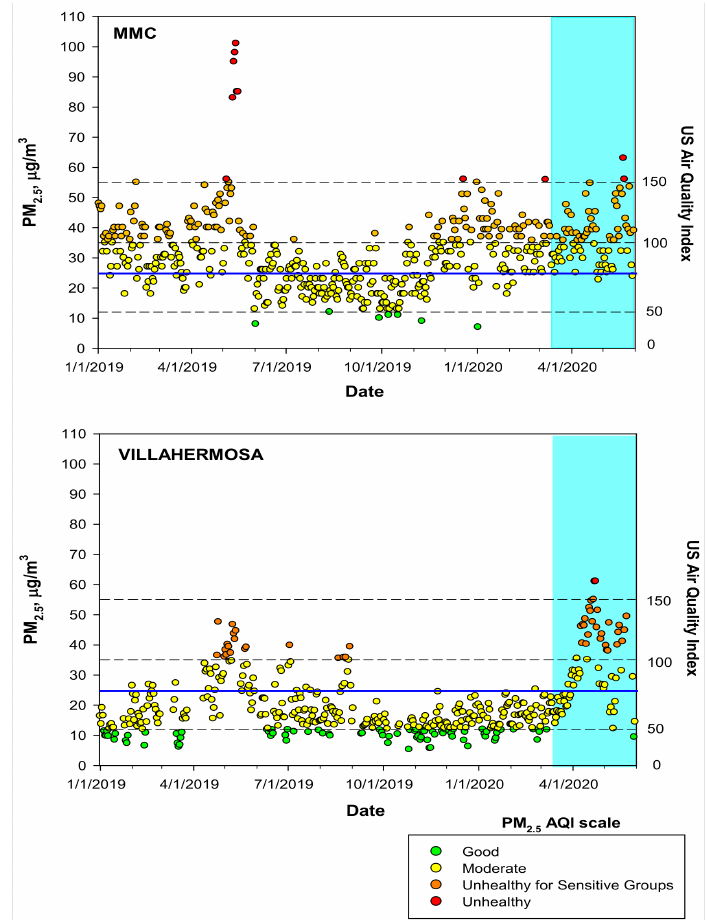
Figure 1. Time-series of maximum PM 2.5 24-h averages at MMC and estimated daily 24-h averages at MAVH January 2019 to May 2020—including the 11 m study period—classified according to the US EPA AQI index. The blue continuous line depicts the 24-h average WHO guideline. The blue shade area represents the beginning of the COVID-19 official lockdown in Mexico. Air quality data were available from the Sistema de Monitoreo Atmosf é rico del Gobierno de la Ciudad de M é xico (http://www.aire.cdmx.gob.mx/default.php, accessed on 29 December 2021 and Sistema Nacional de Informaci ó n de la Calidad del Aire. Instituto Nacional de Ecolog í a y Cambio Clim á tico (INECC), M é xico (http://sinaica.inecc.gob.mx/data.php, accessed on 29 December